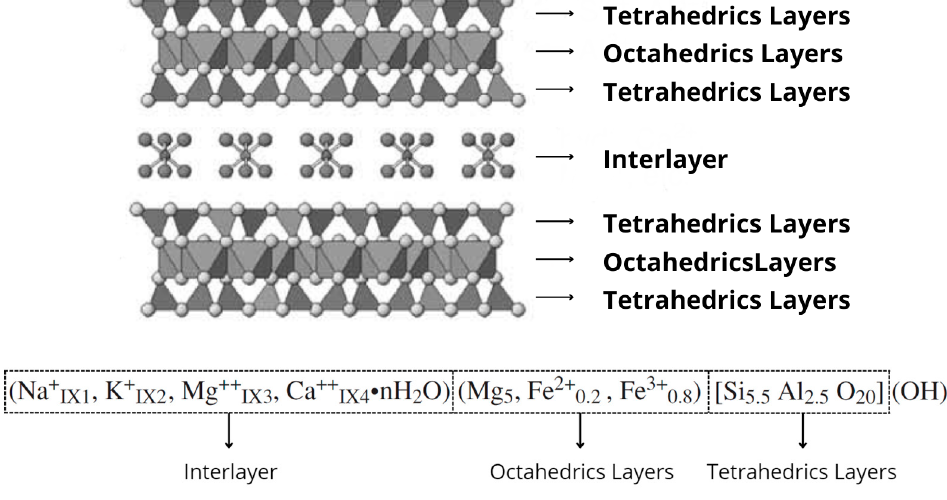
Figure 2. Chemical composition of vermiculite [12,14].